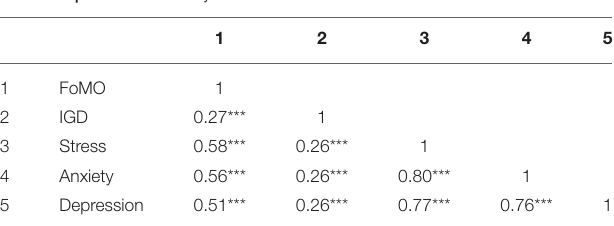
TABLE 2 | Correlation Analysis of each